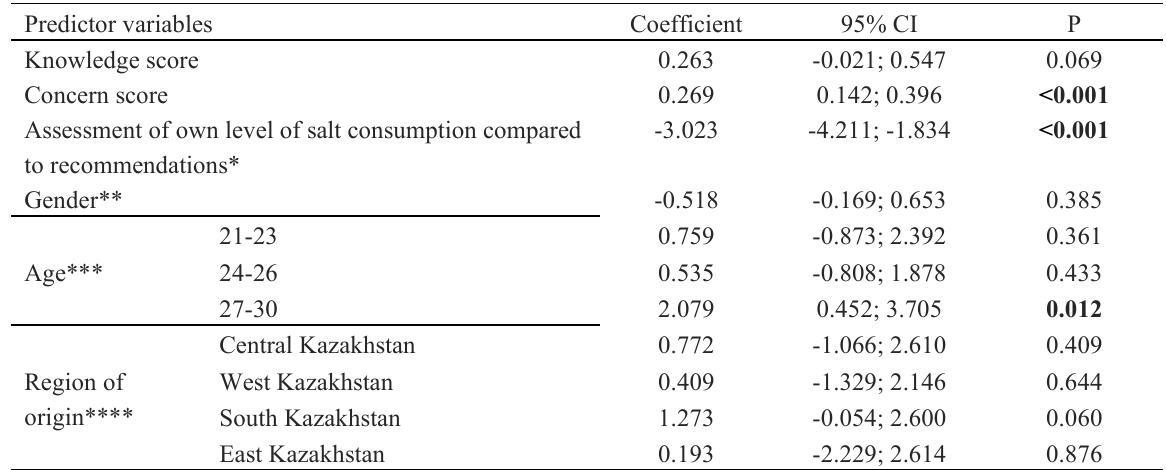
Table 3. Multivariate model: predictors of salt-reducing